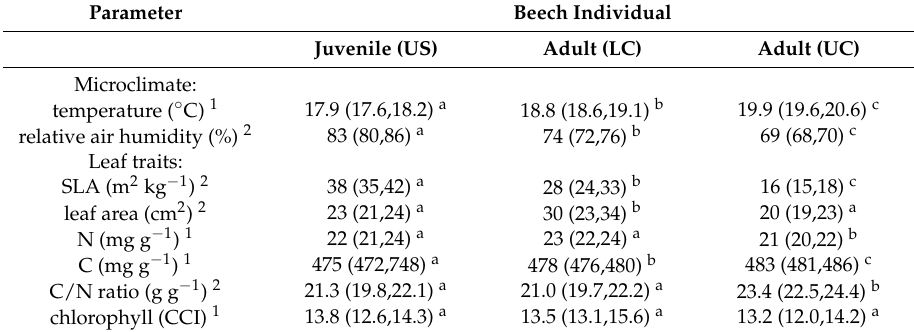
Lowercase letters indicate significant differences of parameters between the forest layers using (1) ANOVA and Tukey's HSD ( p ≤ 0.05; df = 2) or (2) Kruskal-Wallis and post-hoc test ( p ≤ 0.05; df = 2). CCI = chlorophyll content